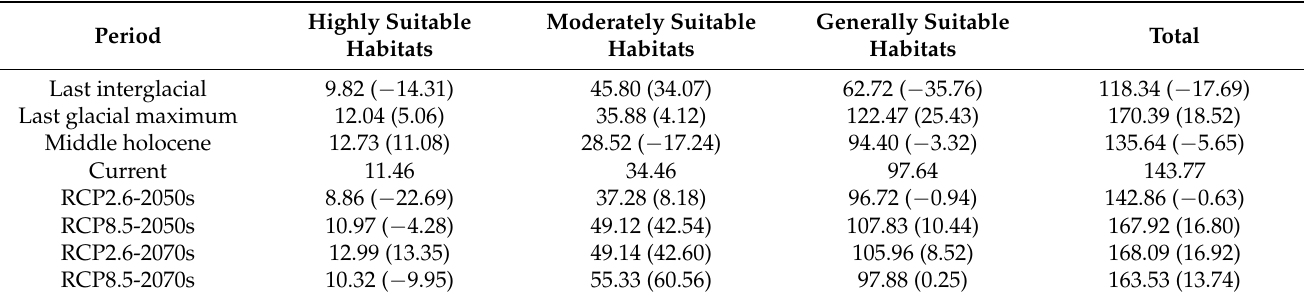
Table 2. Changes of the suitable area of G. pensilis in different periods (unit: × 10 4 km 2 ). Values in parenthesis represent proportion of areas (%).